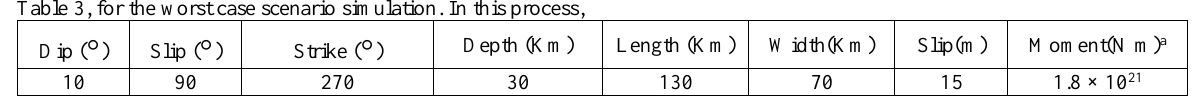
Table 3. Seismic parameters of the Makran tsunami of the worst case tsunami